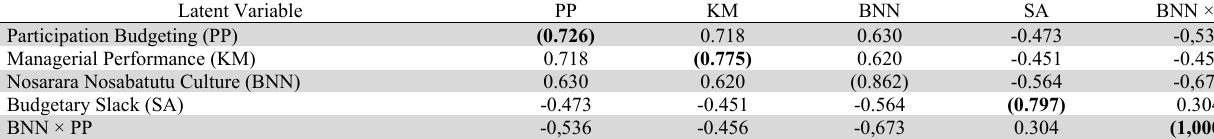
The summary of discriminant validity (Continued)